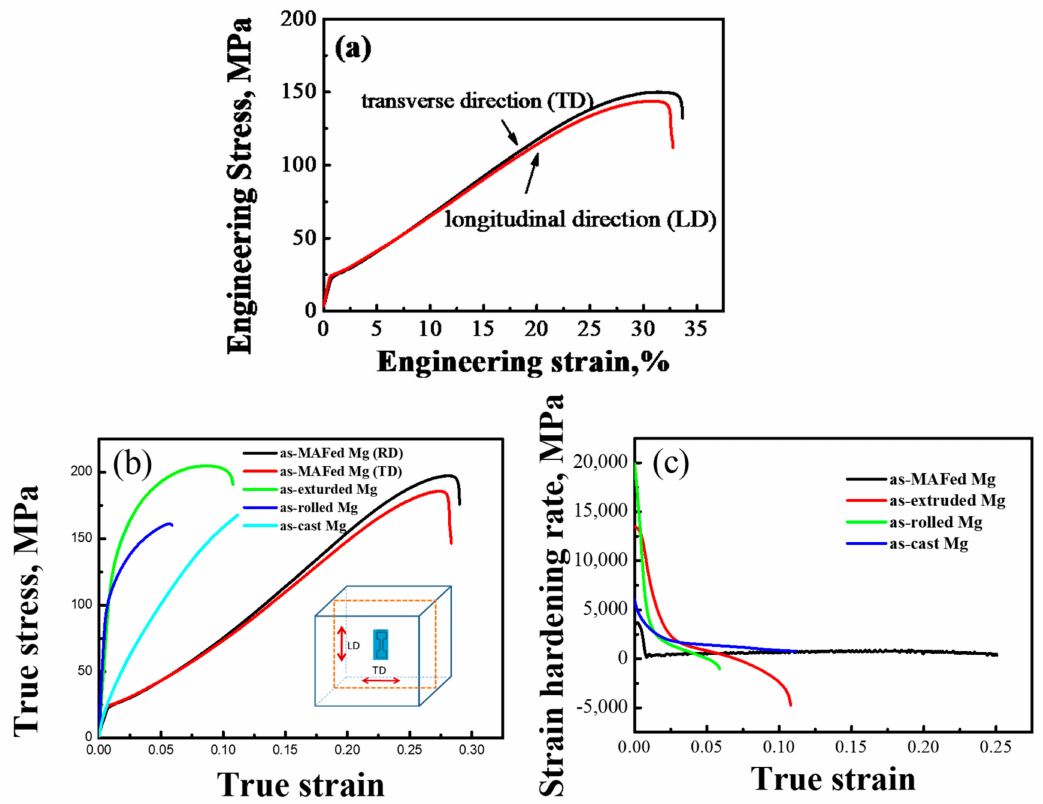
Figure 2. ( a , b ) Showing the engineering stress-engineering strain and true stress-true strain curves of as-MAFed, as-extruded, as-rolled, and as-cast pure Mg at a strain rate of 1 × 10 –3 s –1 at room temperature; ( c ) shows the true strain hardening rate as a function of true strain of the as-MAFed, as-extruded, as-rolled, and as-cast pure